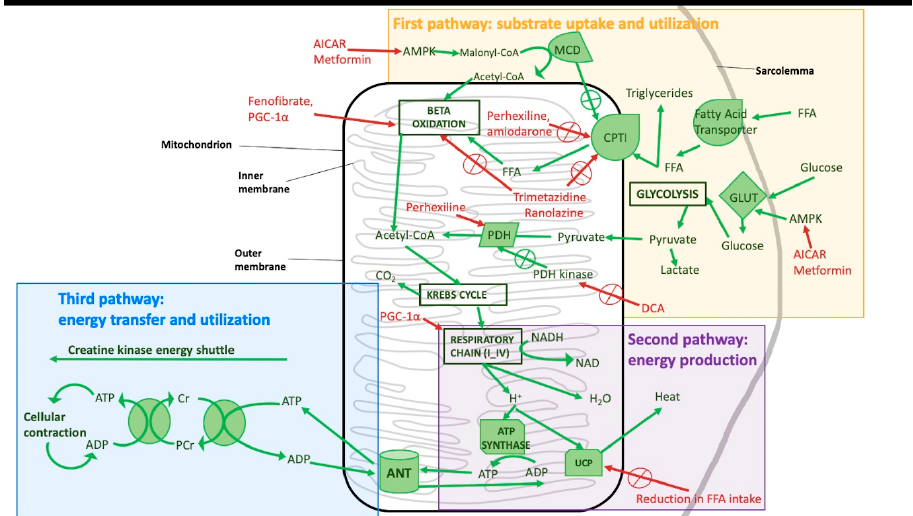
Figure 1. Metabolic derangements in the failing myocardium. AICAR: 5 ′ -aminoimidazole-4-carboxyamide-ribonucleoside; MCD: malonyl-CoA decarboxylase; PGC-1 α : proliferator-activated receptor- γ coactivator 1 α ; CPTI: carnitine palmitoyl transferase I; FFA: free fatty acids; GLUT: glucose transporters; PDH: pyruvate dehydrogenase; PCr: phosphocreatine, ANT: Anthracyclines, such as Doxorubicin; UCP: mitochondrial uncoupling proteins.